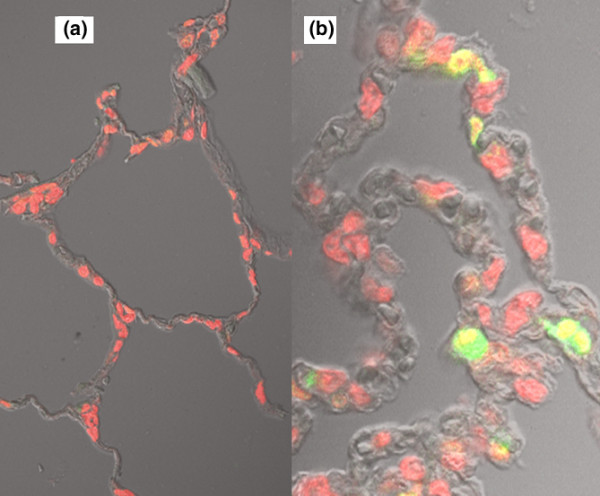
Representative results of TUNEL staining. Alveolar parenchyma from left lower lobe: (a) Nonischemic (group i) and (b) ischemia/reperfusion injury (group ii). Note that there are more bright green cells in panel b than in panel a, indicating more apoptosis. TUNEL, TdT-mediated dUTP nick end labeling.